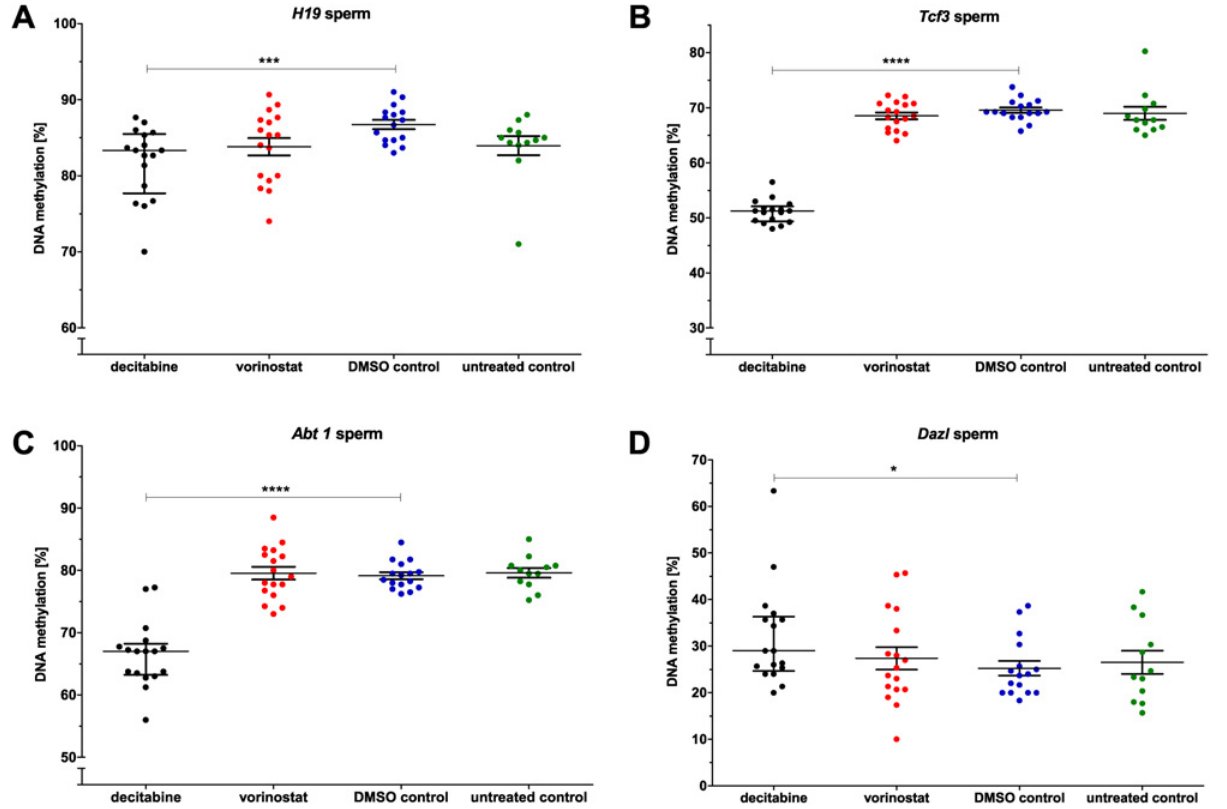
Fig 4. Direct effects of decitabine and vorinostat on DNA methylation in spermatozoa of the P-generation. Genes: A) H19 , B) Dazl , C) Abt1 and D) Tcf3 . Statistical differences were calculated for decitabine and vorinostat in comparison to DMSO vehicle control and for DMSO vehicle control in comparison to untreated control mice. One point represents one animal. The median ( ± interquartile range) is shown for each group, * : p < 0.05, ** : p < 0.01, *** : p < 0.001, **** : p <